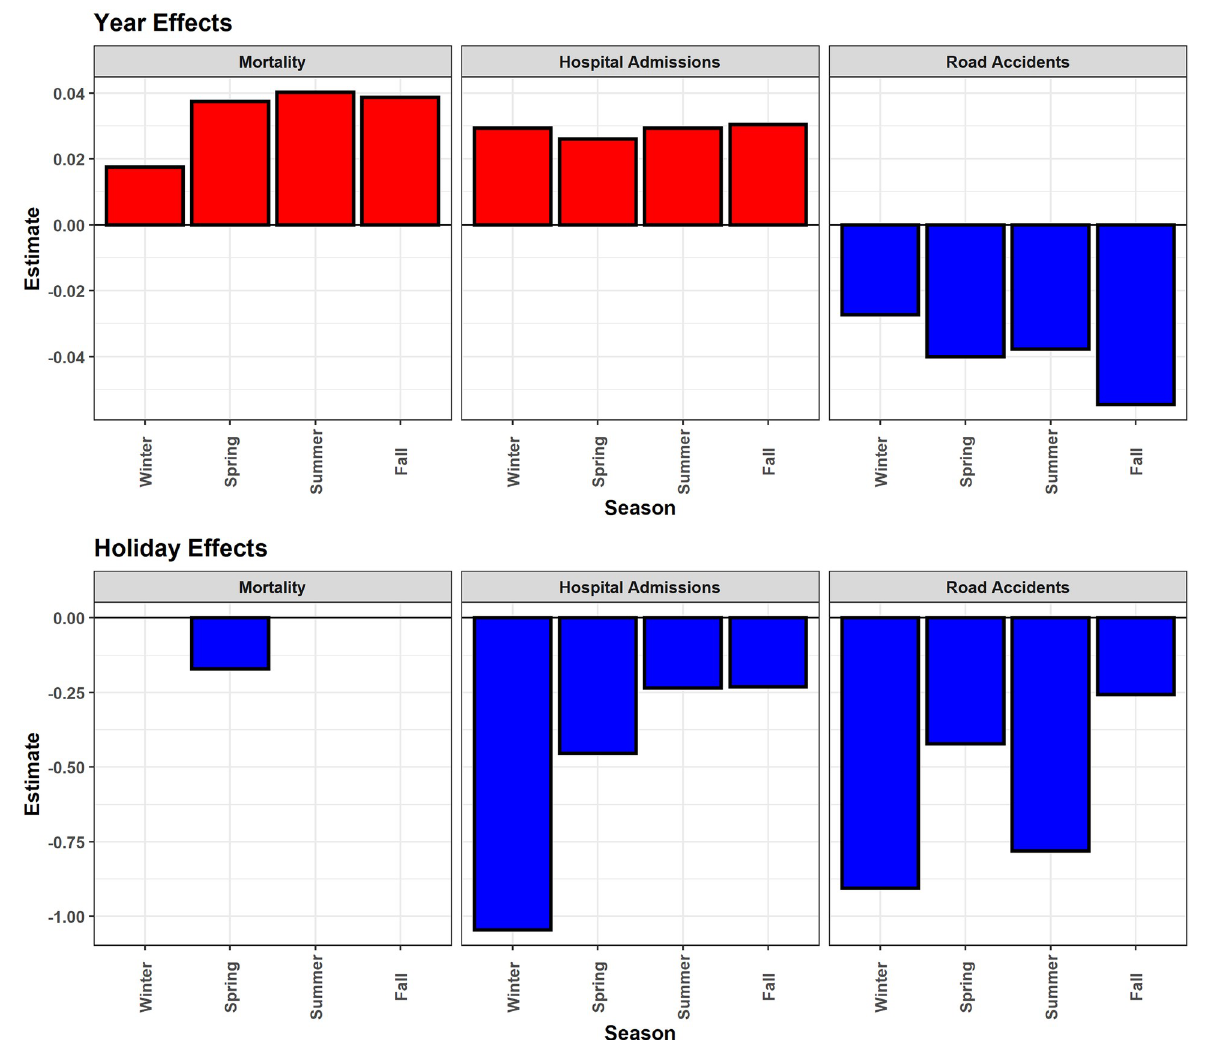
Fig 6. Year and holiday effects. Year and holiday effects on daily mortality, hospital admissions, and road accidents for each season, expressed as a proportion of the standard deviation of the respective daily number of cases within Bavaria. The absence of a column means that the effect of the year or holiday was not significant in the corresponding model. Explanatory example: For winter hospital admissions, the sd is 3143.5 (see Table 1), and the year effect for Bavaria is 0.02933. This indicates an increase in daily hospital admissions by 0.02933 � 3143.5 = 92.2 every year.